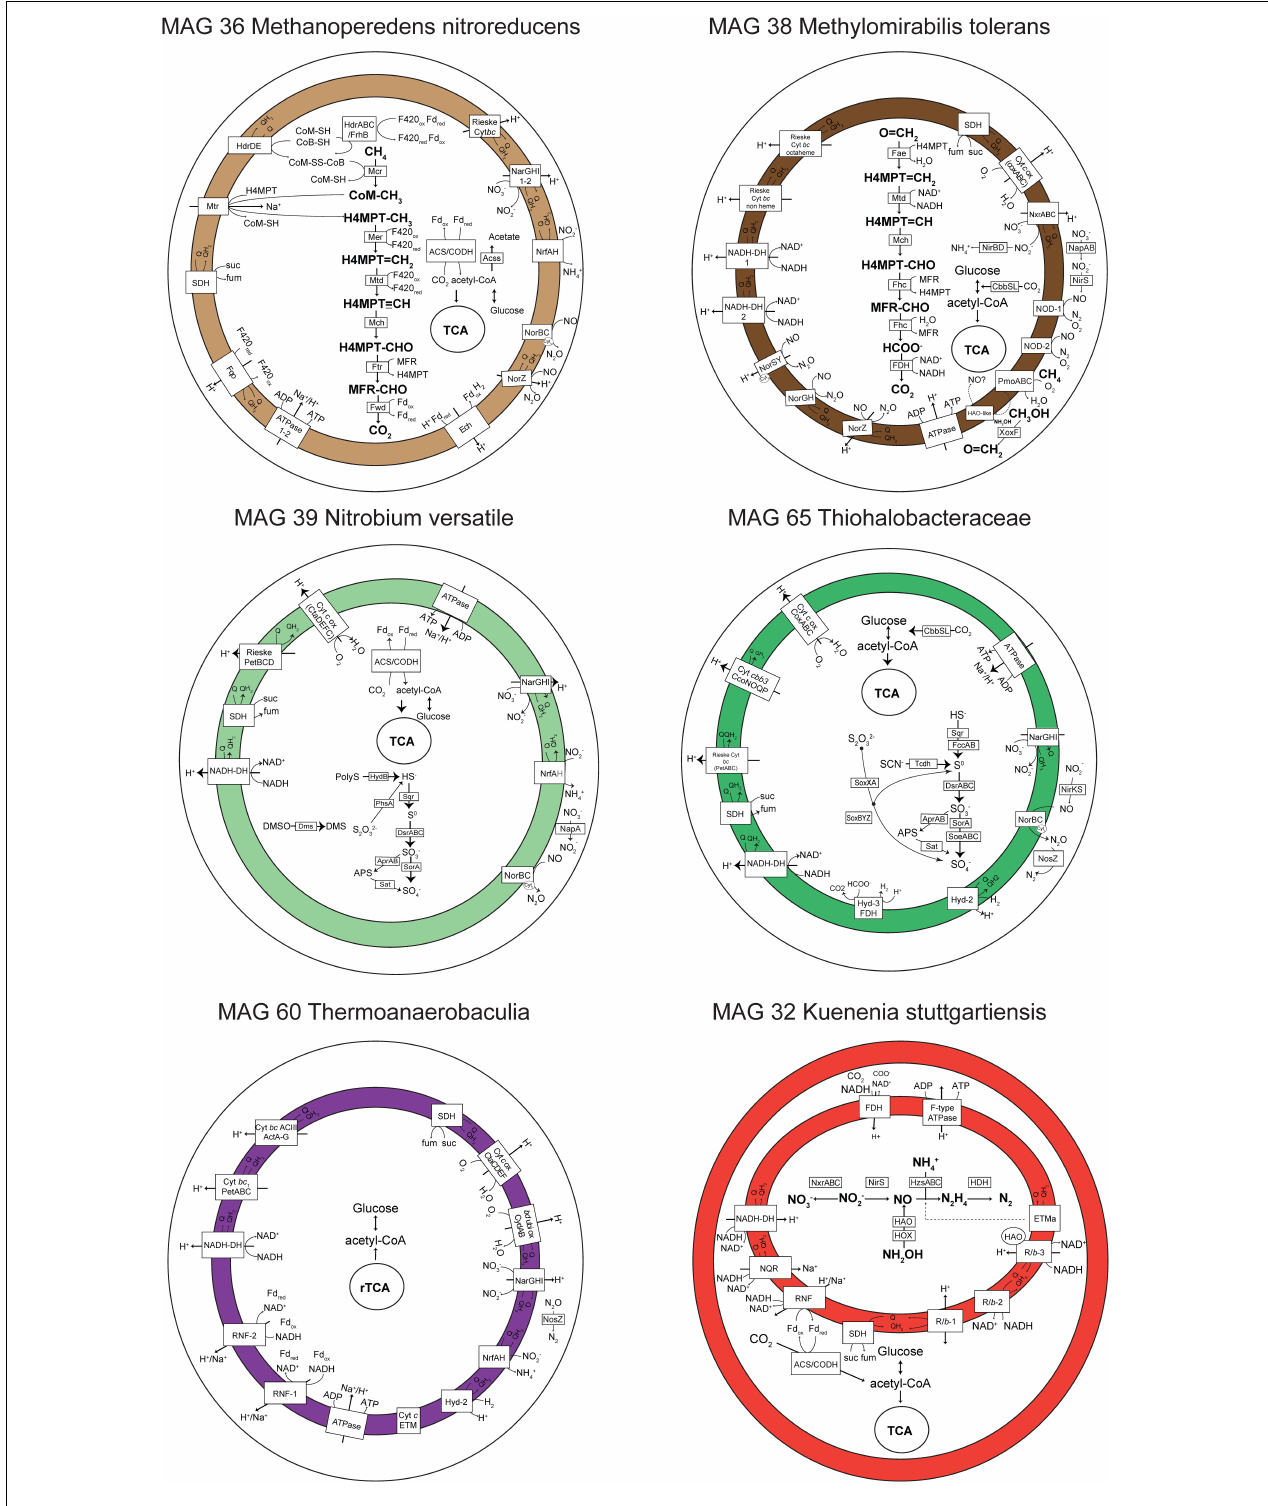
FIGURE 4 | Metabolic reconstruction of six genomes of interest. Only genes with TPM > 0 in metatranscriptomic analyses are shown in selected time points in which the highest number of genes were transcribed (T5 for MAGs 36, 60, and 65, T4 for MAG 38, and T0 for MAGs 32 and 39). Gene abbreviations, loci, and annotations are provided in Supplementary Table 4 . The gene nrfH was absent in MAG 39 Ca. Nitrobium versatile (in gray), but it was previously identified in the first MAG representing this organism (Arshad et al., 2017). In MAG 32 Ca. Kuenenia stuttgartiensis , the internal compartment represents the anammoxosome.